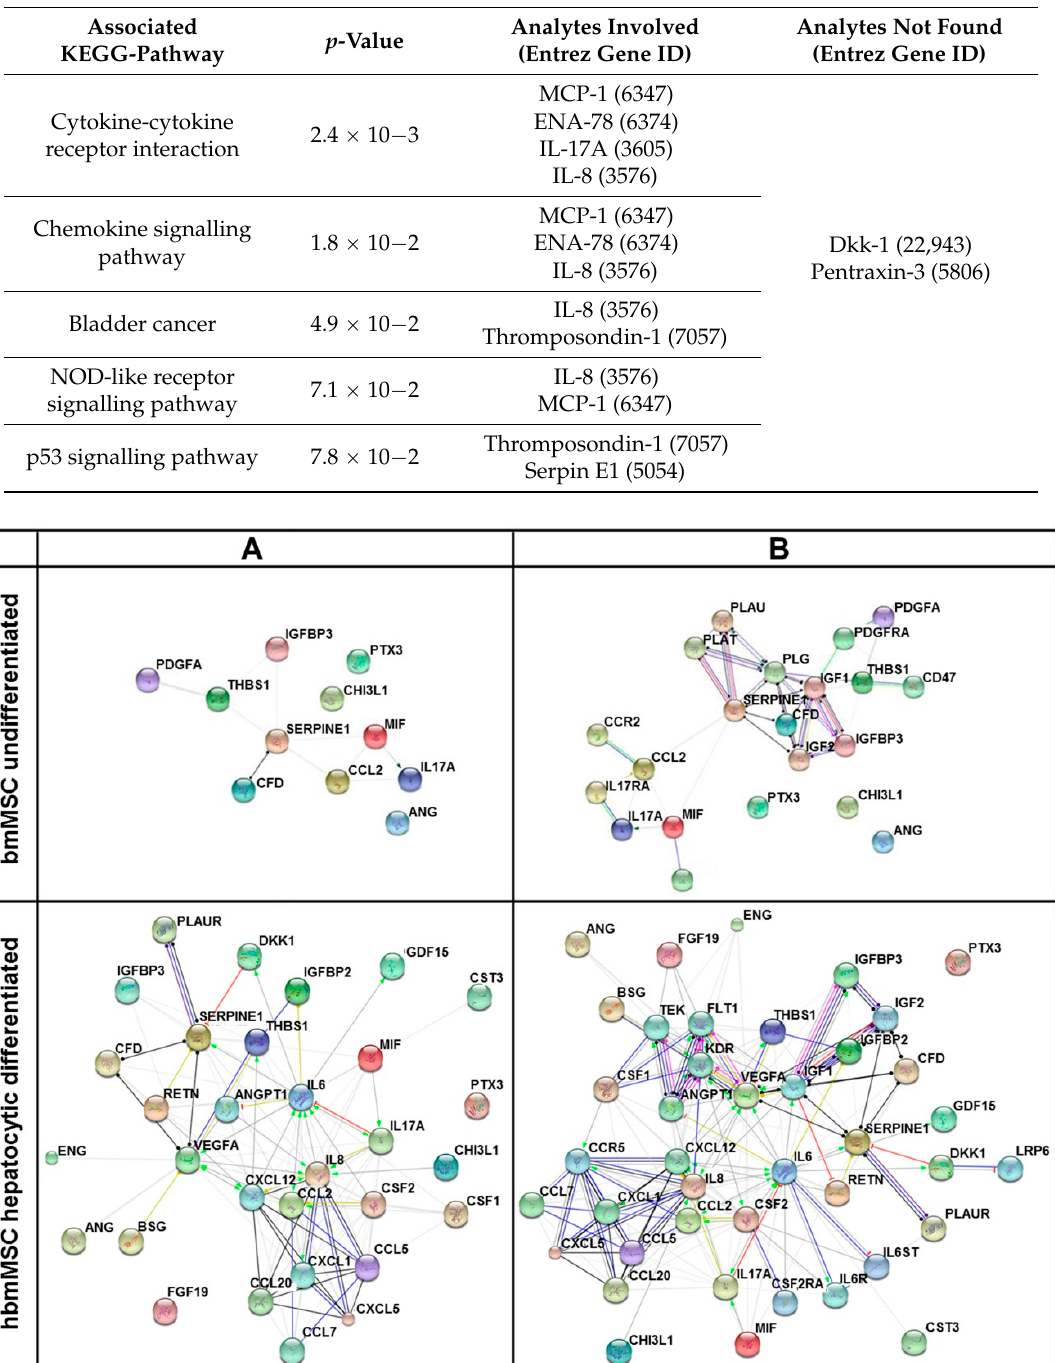
Figure 6. Network of interacting cytokines ( A ) and additional 10 predicted potential interaction partners ( B ) of undifferentiated ( upper panels) and hepatocytic differentiated ( lower panels) hbmMSC. Networks were created by the STRING database using only proteins secreted to high abundance as summarized in Tables S1 and S3. Connections between partners are shown in different colours; green : activation, red : inhibition, blue : binding, cyan : phenotype, violet : catalysis, pink : posttranslational modification, black : reaction, yellow : expression. Bubble coloursare only for a better discrimination.